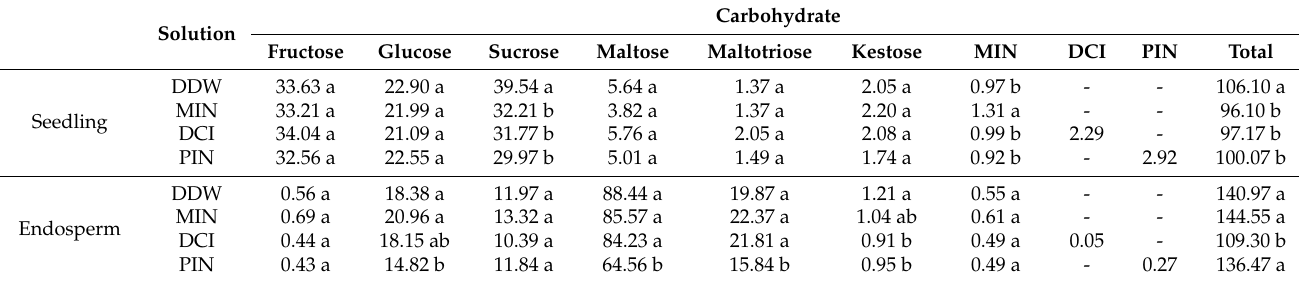
Table 1. The soluble carbohydrate contents in 4-day-old wheat ( Triticum aestivum L. cv. Ostka Strzelecka) seedlings after 24 h seed imbibition in double-distilled water (DDW) or aqueous solutions of myo -inositol (MIN), D - chiro -inositol (DCI) or D -pinitol (PIN) at a concentration of 100 mM each. Values (in mg/g DW) are means of three replicates. The same letters by the values indicate that there were no significant ( p < 0.05) differences after ANOVA test and Tukey’s post hoc